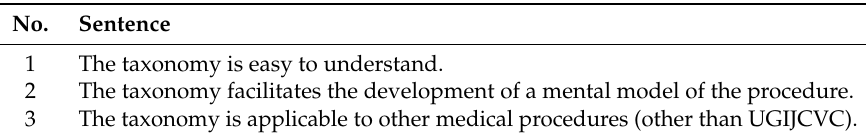
Table 3. Sentences to rate the taxonomy.